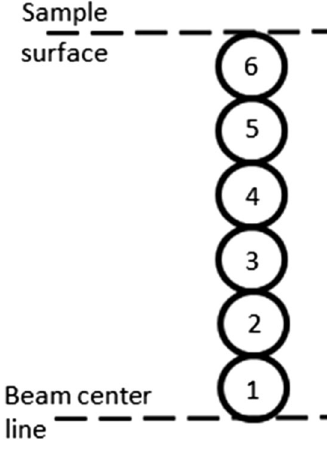
FIG. 8. Simple model of stack of six 1 mm diameter particles.